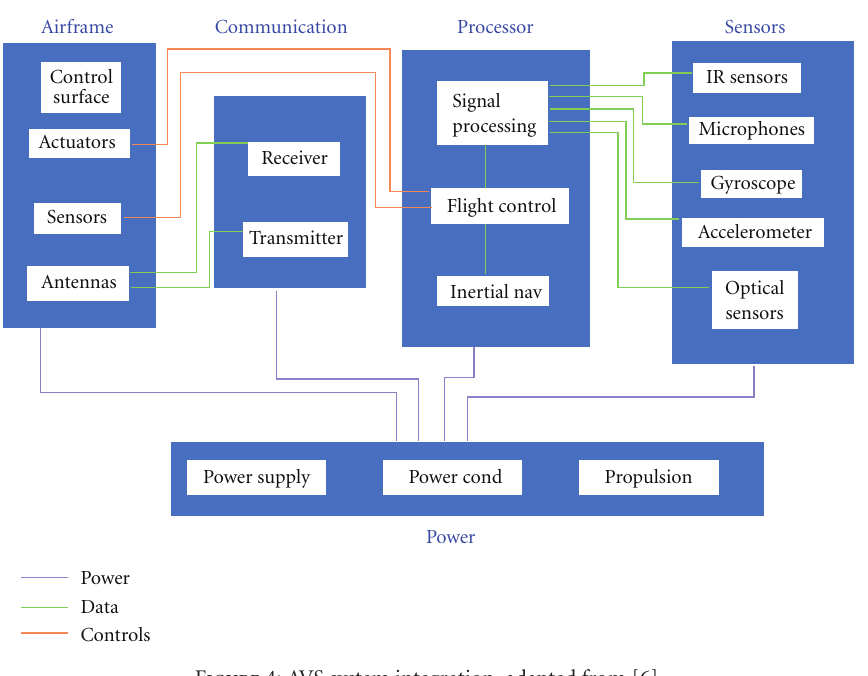
Figure 4: AVS system integration, adapted from [6].